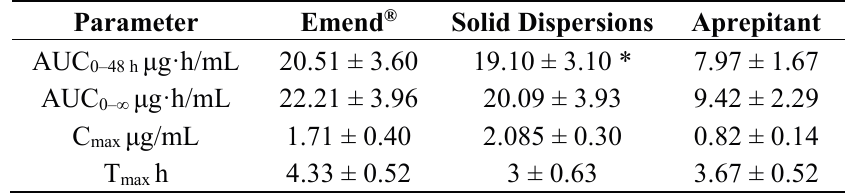
Table 1. Pharmacokinetic parameters following oral administration of solid dispersions and Emend ® ( n =